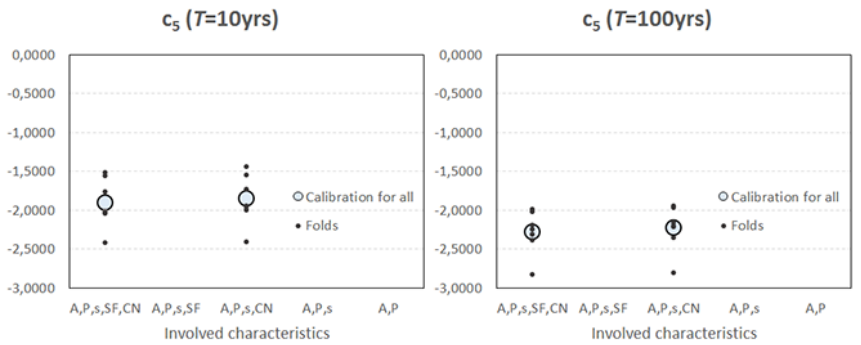
Figure 25. Values of parameter c 5 calibrated to the whole data set and to 7 folds for N = 10 years (left panel) and N = 100 years (right panel).